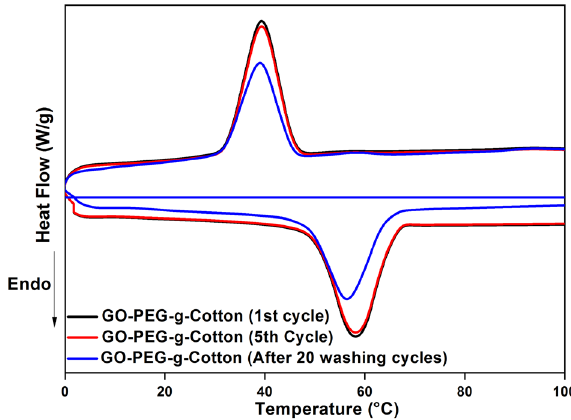
Figure 7. DSC thermogram of